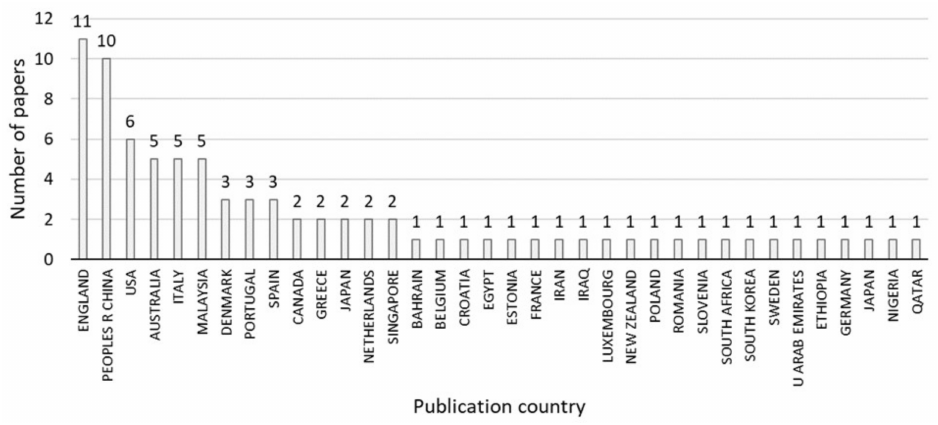
Figure A4. Papers found for each